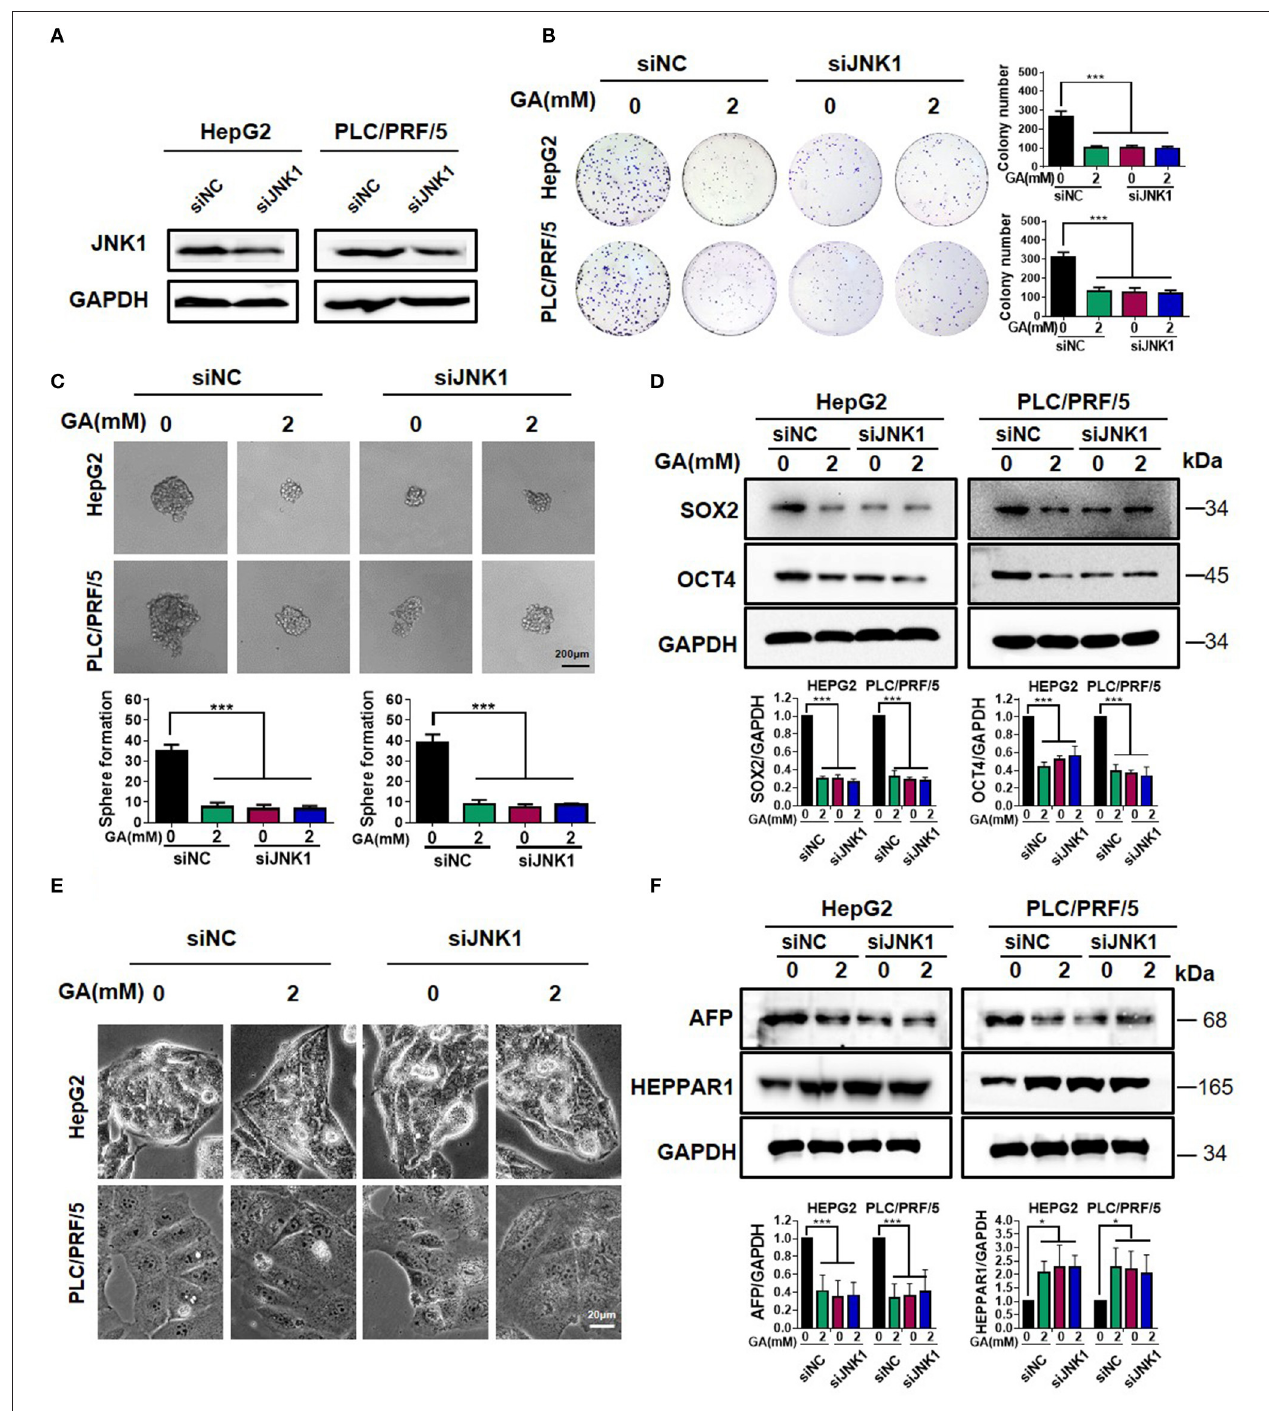
FIGURE 4 | GA reduces stemness and induces differentiation by targeting JNK1. (A) JNK1 expression in HepG2 and PLC/PRF/5 cells after being transfected with siNC and siJNK1 plasmids. Colony formation assay (B) and sphere formation assay (C) in HepG2 and PLC/PRF/5 cells transfected with siNC and siJNK1, followed by treatment with DMSO or GA (2mM) for 48h. The numbers of colonies and spheres were compared (one-way ANOVA; *** P < 0.001). (D) . Expressions of representative CSC markers (SOX2 and OCT4) were analyzed by Western blot assay (one-way ANOVA; *** P < 0.01). (E) Images of HepG2 and PLC/PRF/5 cells transfected with siNC and siJNK1 followed by incubation with DMSO or GA (2mM) for 48h separately. (F) Representative markers of differentiation (AFP and HEPPAR1) were analyzed by Western blot assay (one-way ANOVA; * P < 0.05, *** P < 0.001). Scale bars in (C,E) are at 200 and 20 µ m, respectively.